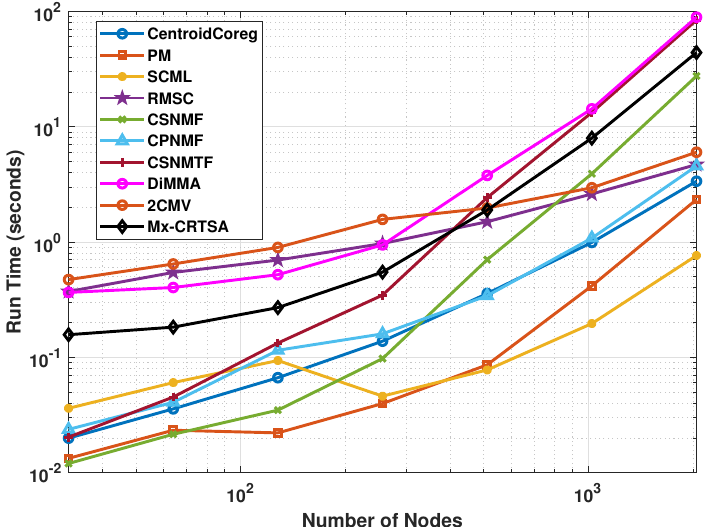
Figure 6. The scalability of Mx-CRTSA compared with other existing methods as the number of nodes